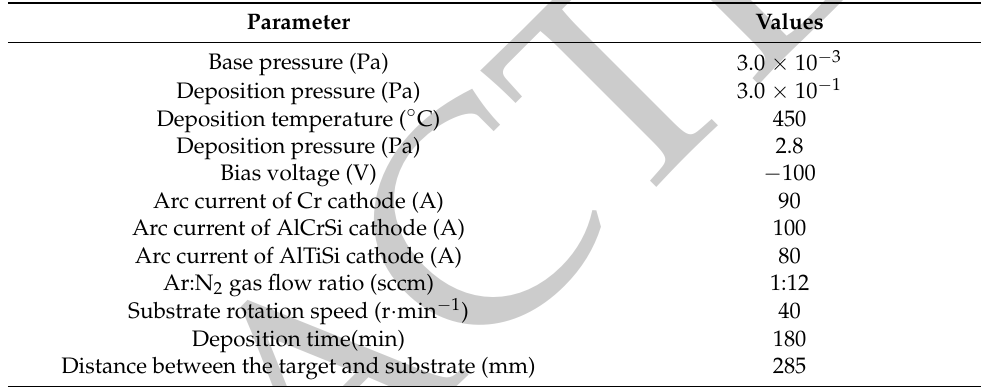
Table 1. Deposition parameters of the AlCrTiSiN coatings prepared by the arc ion plating.